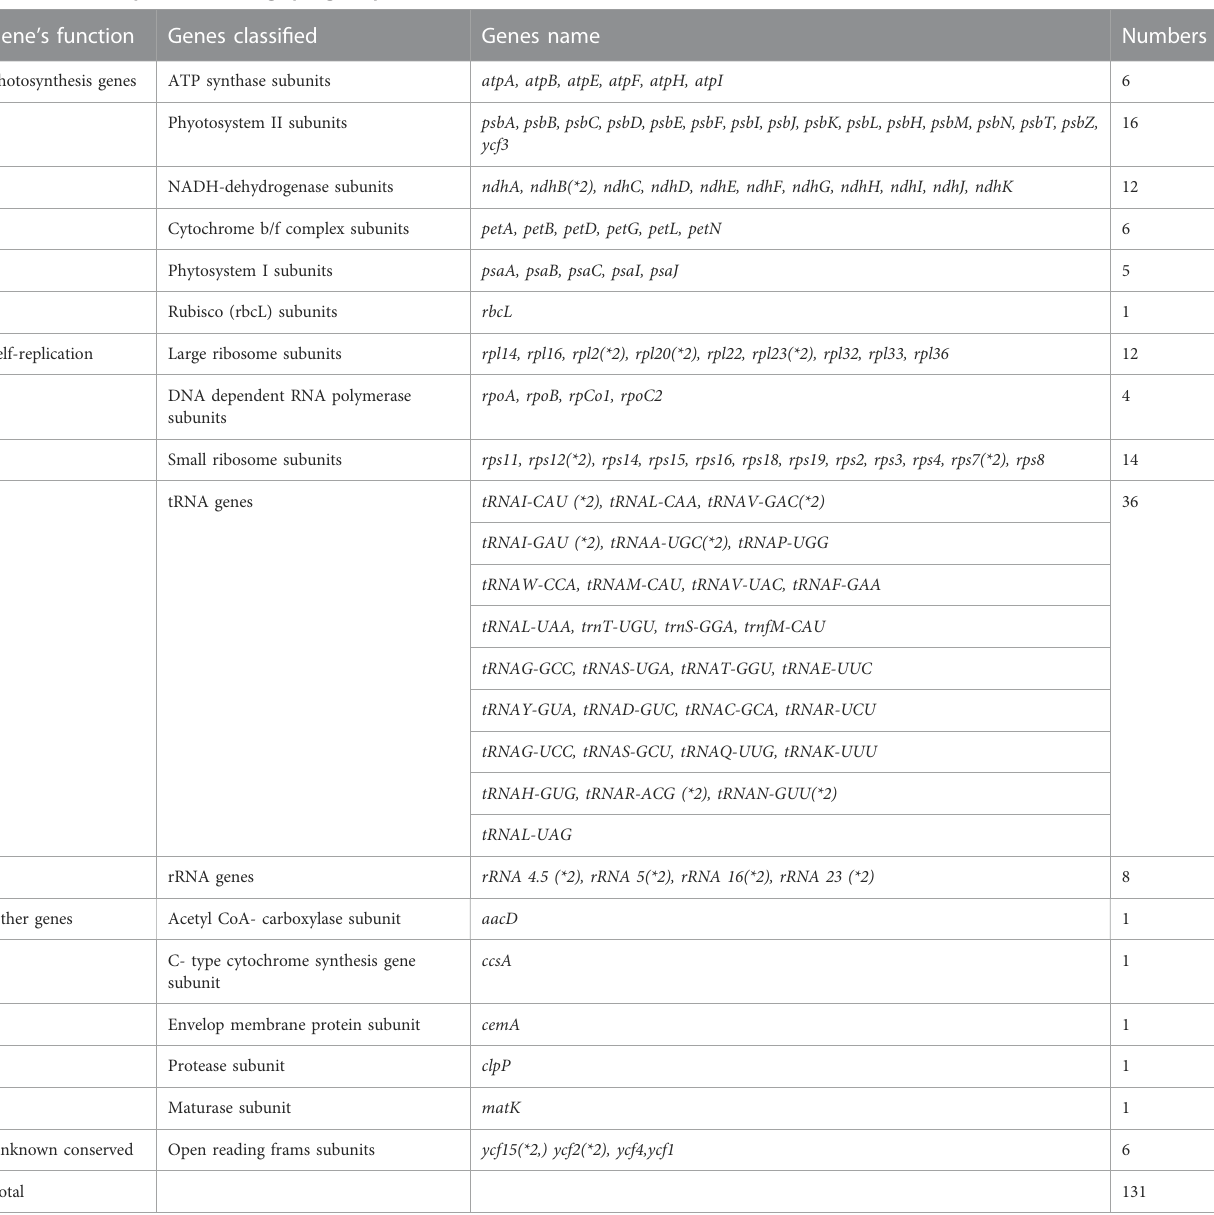
TABLE 1 Genes composition in Moringa peregrina